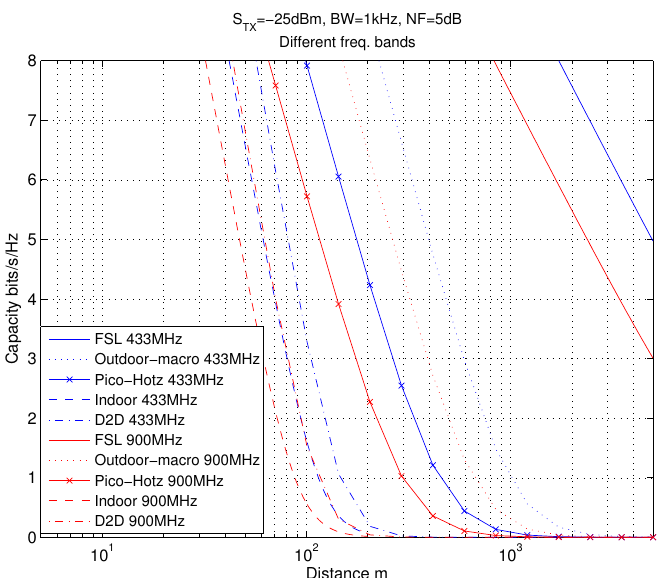
Figure 6. Relative capacity for 802.11ah channels at 433 MHz and 900 MHz bands. Here d BP = 5 for indoor channel. S TX = − 25 dBm, B = 1 kHz, T = 290 K, and NF = 5 dB.